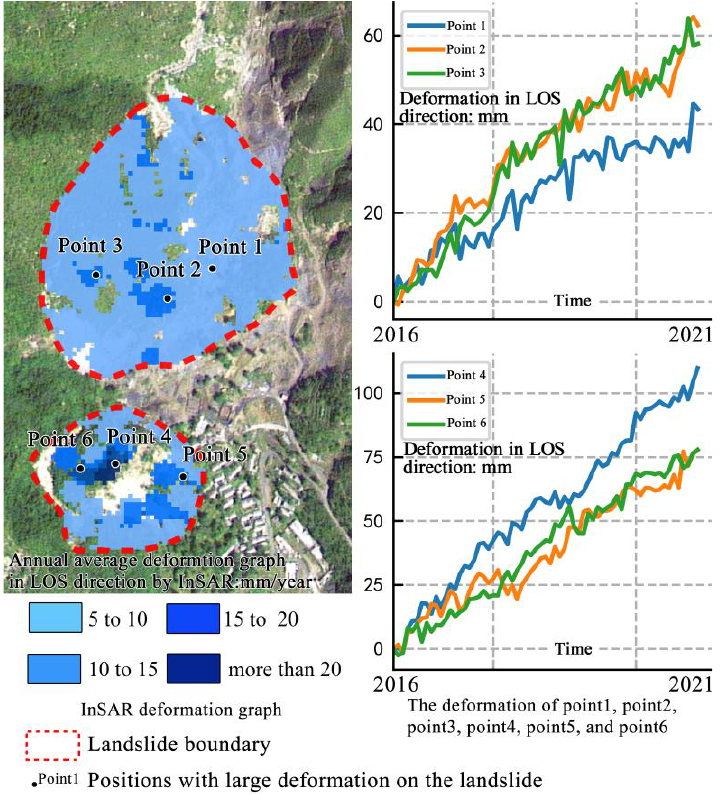
Figure 16. Optical image of landslides S06 and S07 in 2017. F1 denotes the rear part fissure of landslide S07. F1 denotes the rear part fissure of landslide S06.